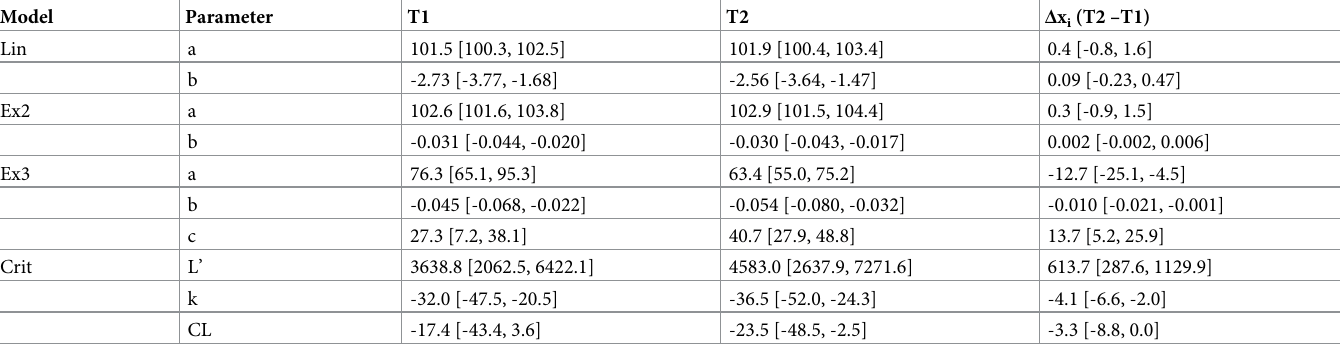
Table 2. Summary of posterior predictive distributions of absolute parameter values during test (T1) and retest (T2). Model